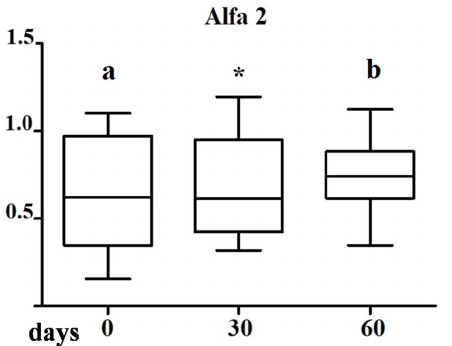
Figure 10. Comparison between the means of the indices, as a function of days, regarding the Alpha 2 (DFA) value, before and after rhinoplasty surgery. Equal letters (“a” and “b”) along that of the columns indicate significant difference at the 5% level. Asterisks (*) along the same line indicate no statistical difference at the 5%